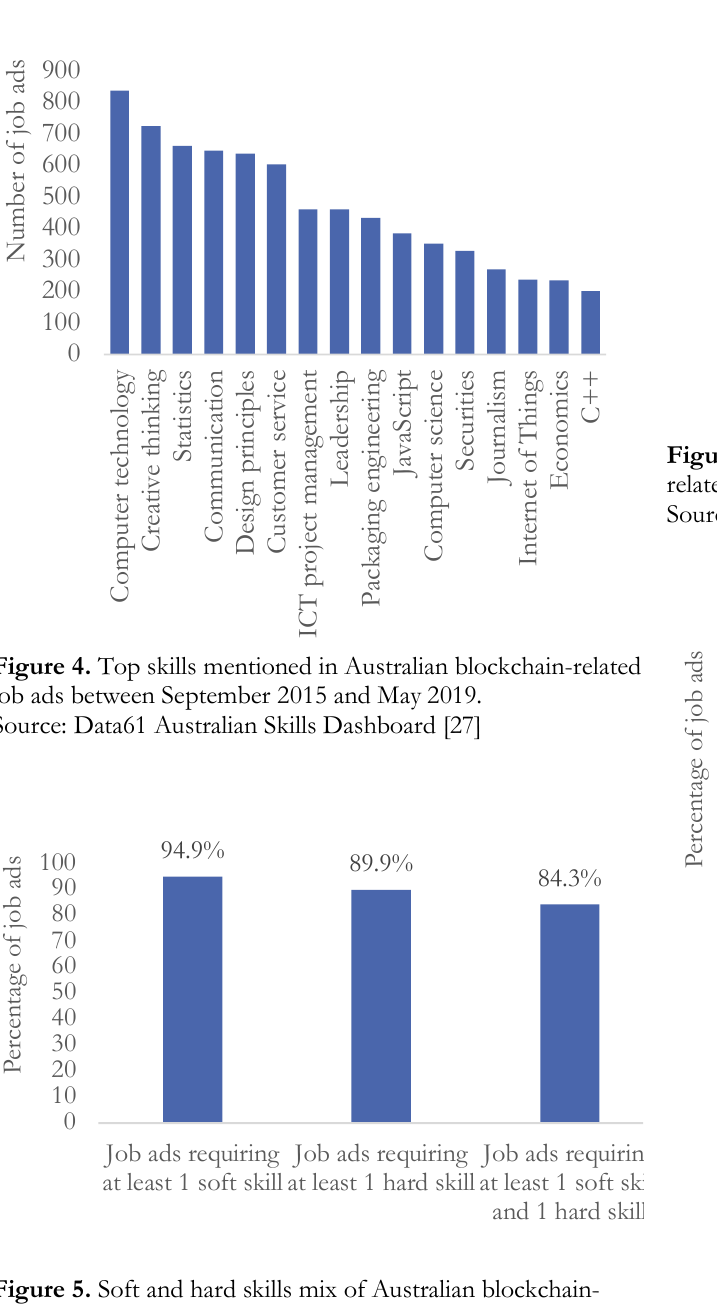
Figure 5. Soft and hard skills mix of Australian blockchain- related job ads between September 2015 and May 2019. Source: Data61 Australian Skills Dashboard [27] Note: 1.4% of the total job ads listed no skills and were excluded from this graph.